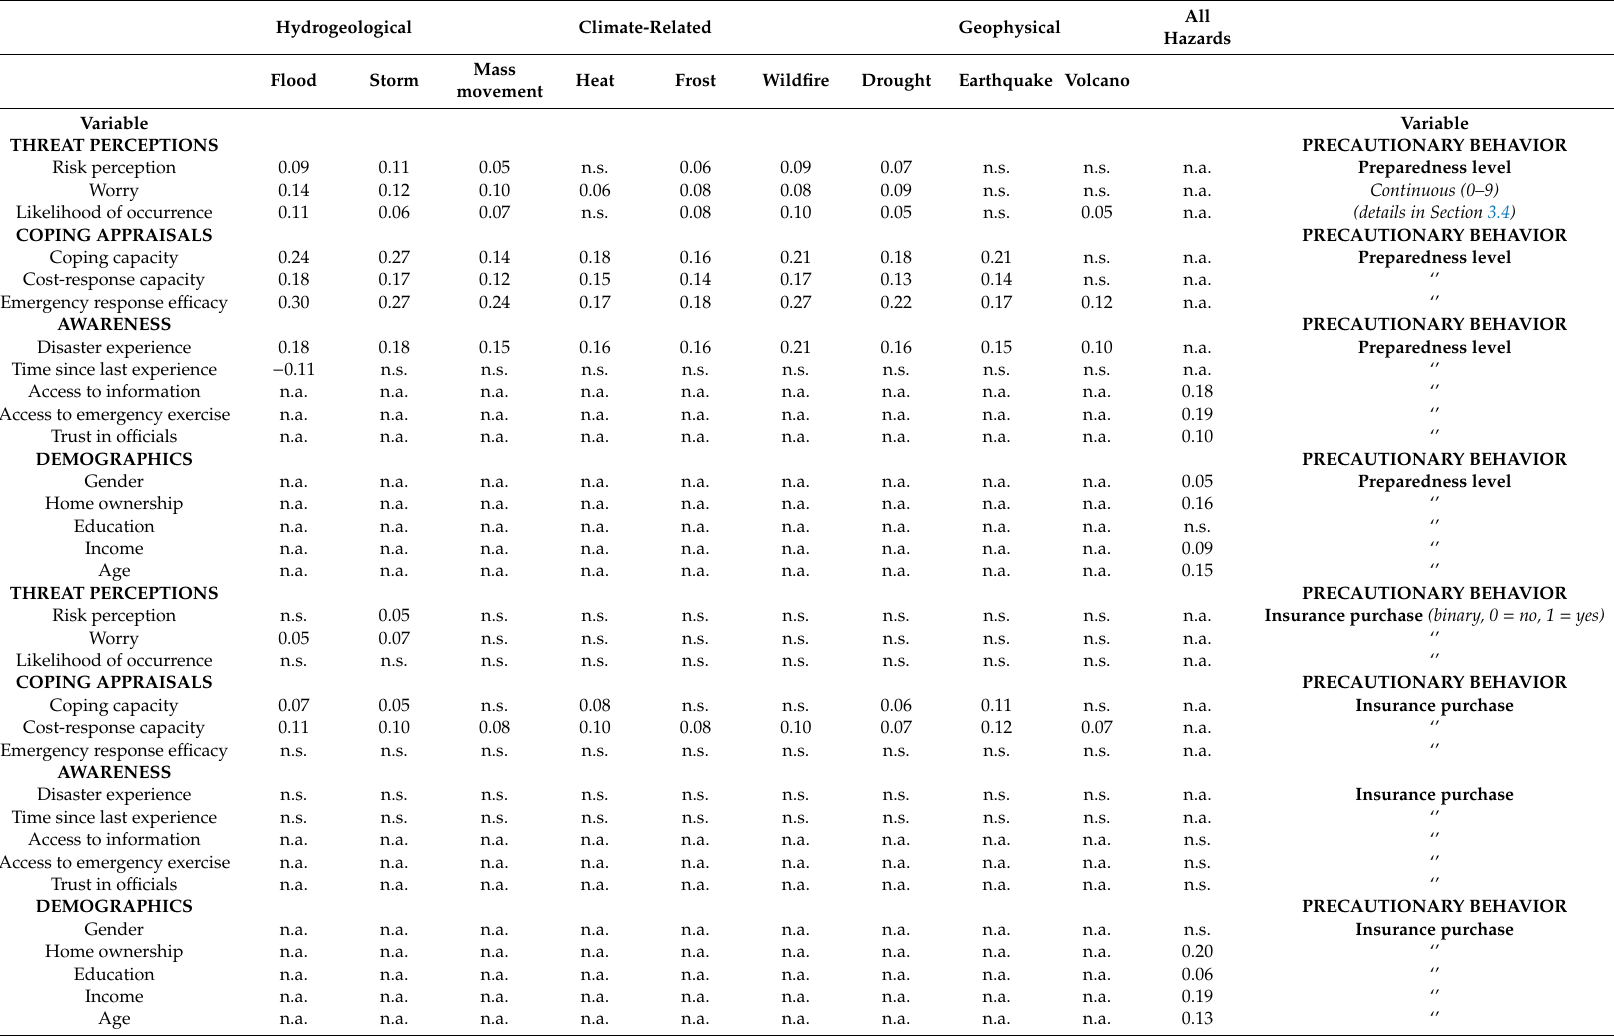
Table A2. Correlations (Spearman’s rho coe ffi cient) between awareness / confidence / demographic variables and precautionary behaviors, per hazard 1